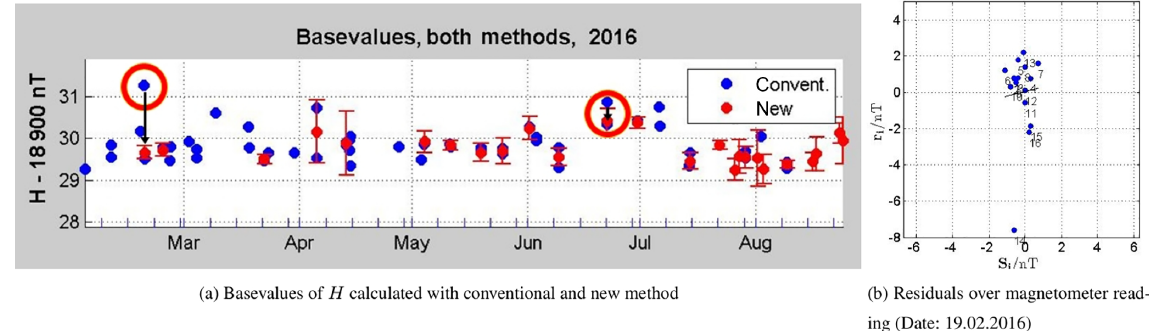
Figure 3. Panel (a) shows conventionally measured baseline values of the H component in NGK in blue. The red points show results obtained with the new method. Calculated error bars allow their quality to be assessed. Red circles show baseline data which could be improved, because typos in the data sheets could be identified and corrected. Panel (b) gives a scatter plot of residuals r i over magnetometer readings S reading ,i , clearly showing an outlier.